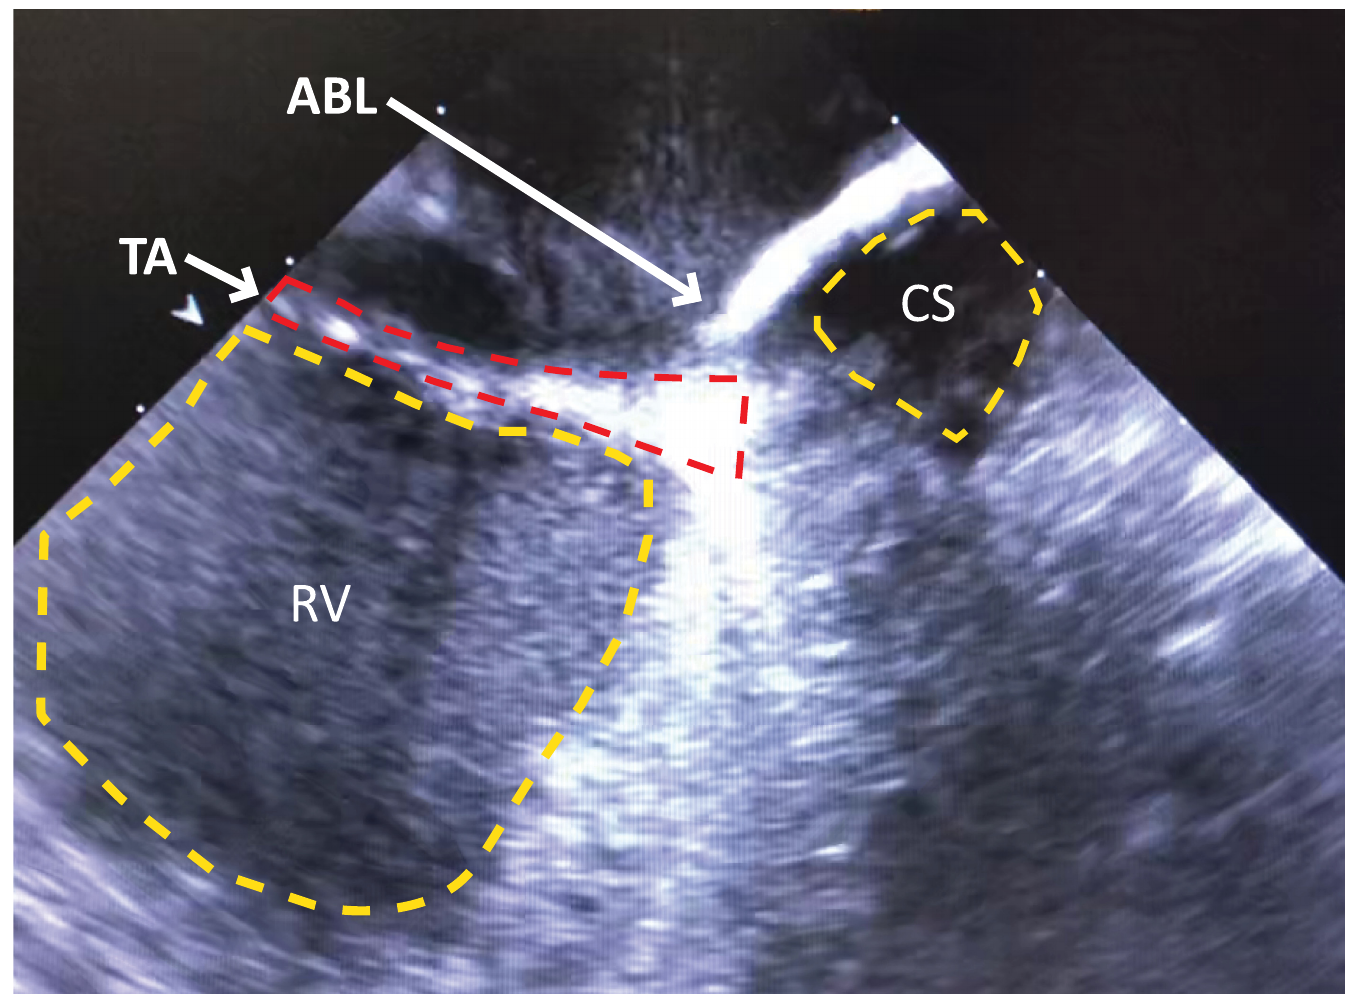
Fig 6. ICE recording confirms site tricuspid annulus (TA) and coronary sinus (CS) to assist with location of His bundle. Representative ICE recording confirming the location of the ablation catheter tip (ACT) at the site of the TA relative to the ostium of the CS and the right ventricle (RV).